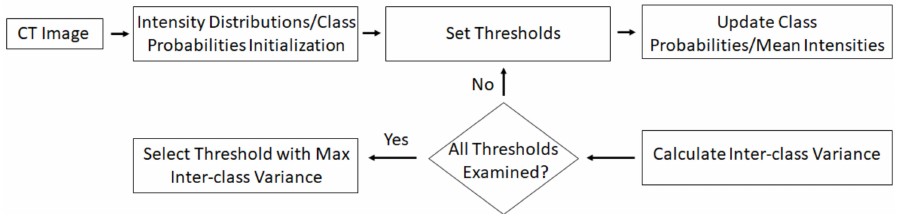
Figure 3. Flowchart for Otsu thresholding.